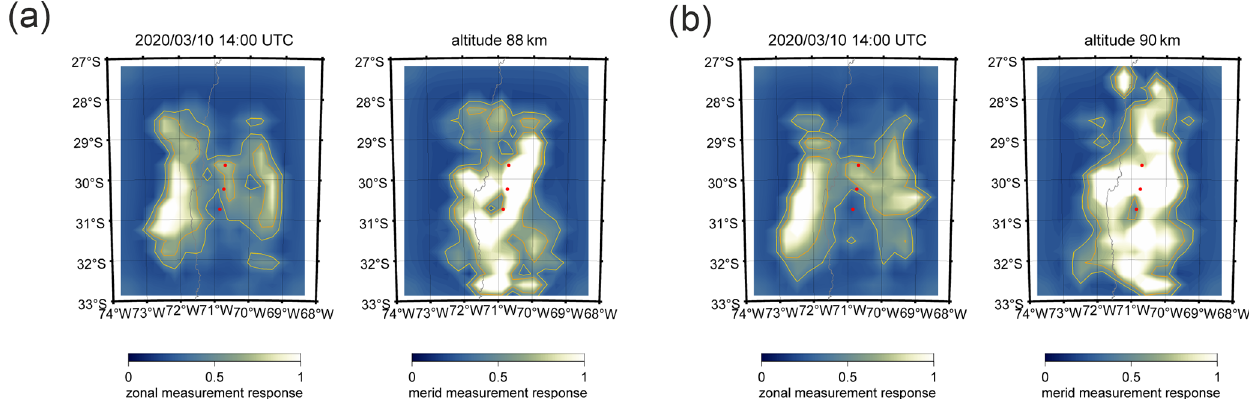
Figure 8. The four panels show the measurement response for the zonal and meridional wind components and both altitudes of the body force event above